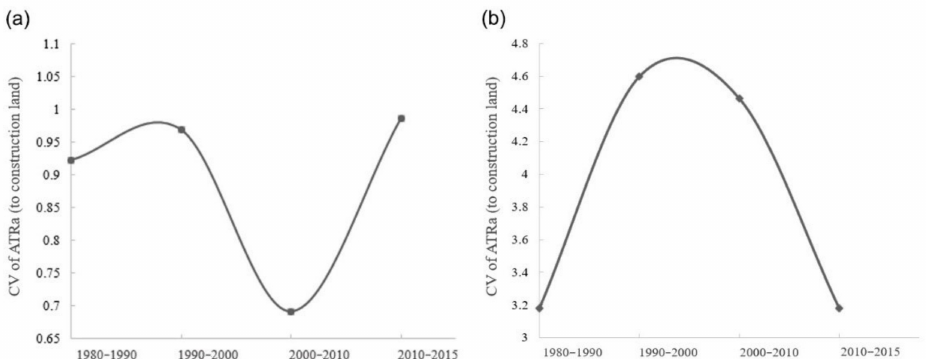
Figure 8. The CVs of ACRa in Chongqing at ( a ) the county/district and ( b ) village level during